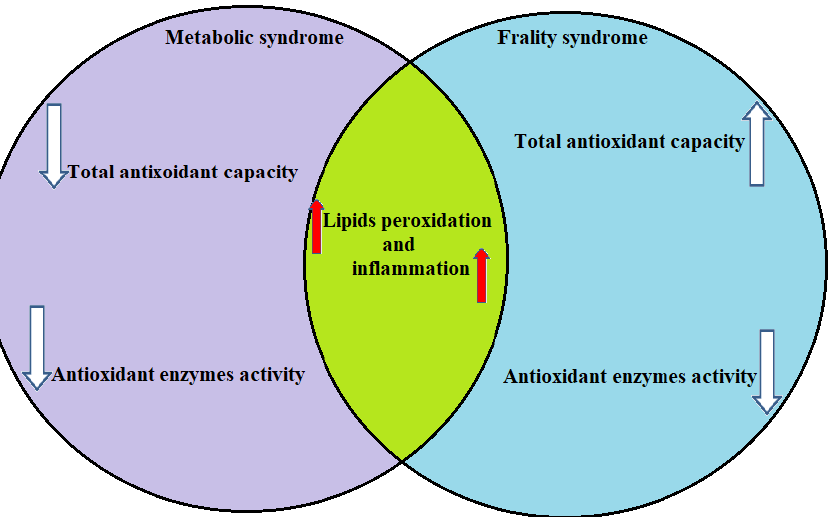
Figure 2. Changes in the inflammation and oxidative stress markers in both metabolic and frailty syndromes.